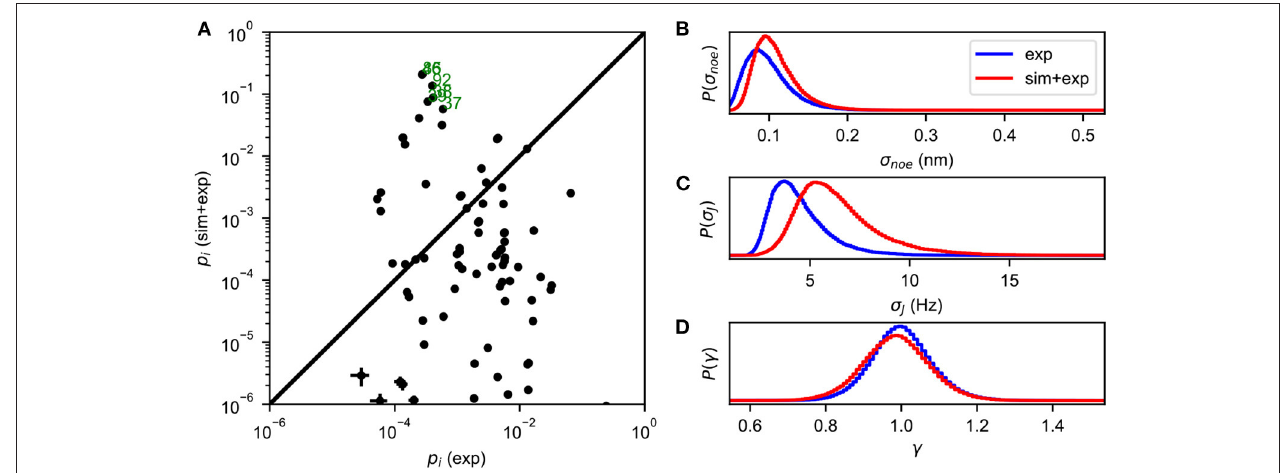
FIGURE 1 | An example of BICePs output for albocycline (Liang et al., 2018). (A) A comparison of conformational state populations p i (exp) inferred using only experimental restraints, vs. BICePs populations p i (sim exp) inferred using a combination of the simulation-based prior and experimental restraints. States on the + lower right are highly compatible with experimental restraints, but are conformationally strained according the simulation model. Conformational states near the top of the graph are both reasonably compatible with experimental restraints, and highly-populated according to the simulation model. States labeled in green correspond closely to the two crystal isoforms of albocycline. (B) The marginal posterior distribution of σ noe , the uncertainty parameter for NOE distance restraints. (C) The marginal posterior distribution of σ J , the uncertainty parameter for J -coupling constants. (D) The marginal posterior distribution of γ , the scaling parameter for the NOE distances, remains near 1.0 throughout the MCMC